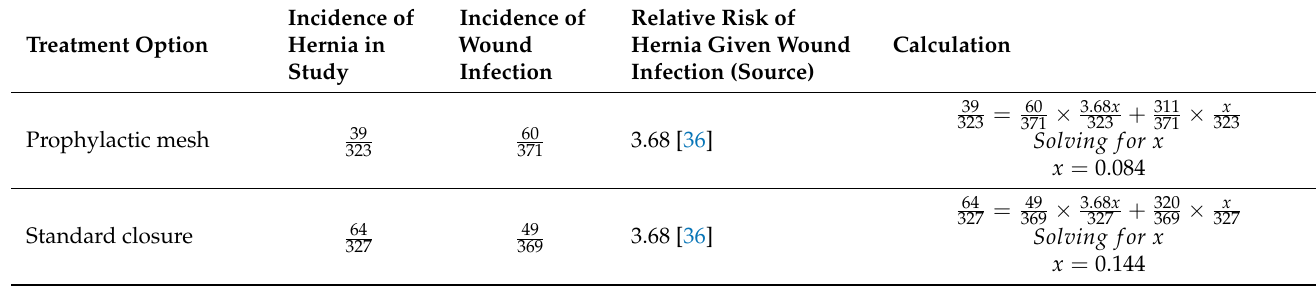
Table A7. Calculations for the incidence of hernia given wound infection.